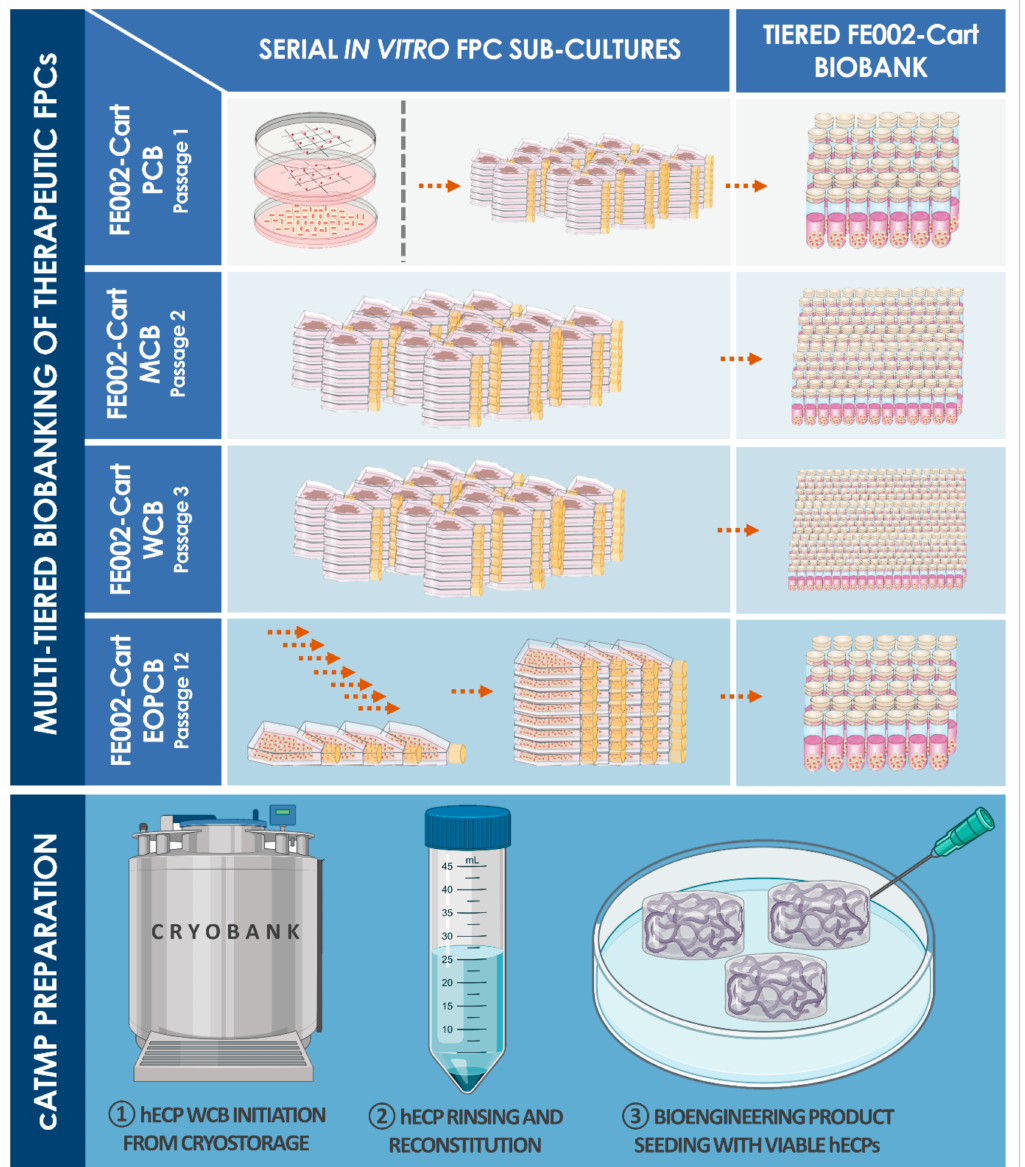
Figure 2. Schematic workflow for optimized and standardized multi-tiered cell banking of primary hECPs (e.g., non- enzymatically isolated FE002-Cart cell type) and cATMP preparation for the clinic. In vitro optimization steps in the pilot expansion study allow one to select the optimally adapted serum manufacturer and lot, two-dimension culture surface size and brand, producing the overall best efficiency of manufacturing. Defined technical specifications and rigorous screening, characterization testing, batch release testing, and safety testing allow for the liberation of highly homogenous, stable, and safe therapeutic biological materials for use in regenerative medicine applications. These considerations and technical specificities are largely dependent on the inherent high robustness, consistency, and stability of properly harnessed FPC sources. Industrial transposition to GMP manufacturing is tangibly attained with such materials, whereas extensive multi-tiered cryopreserved cell banks may be rapidly and efficiently established as proposed herein. Presented bank tiers and passage nomenclature were validated for the FE002-Cart cell type. Off-the-freezer use of such FPC sources enables simple, extemporaneous, and the on-demand production of